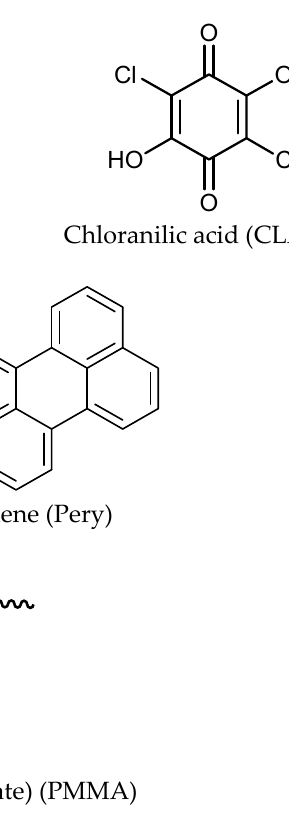
Figure 1. Chemical structures of PMMA, perylene donor and PA and CLA acceptors. The preparation of the charge-transfer (CT) complex of PMMA-perylene dye, PMMA-perylene-PA and PMMA-perylene-CLA polymer sheets was reported by Altalhi et al. [18].